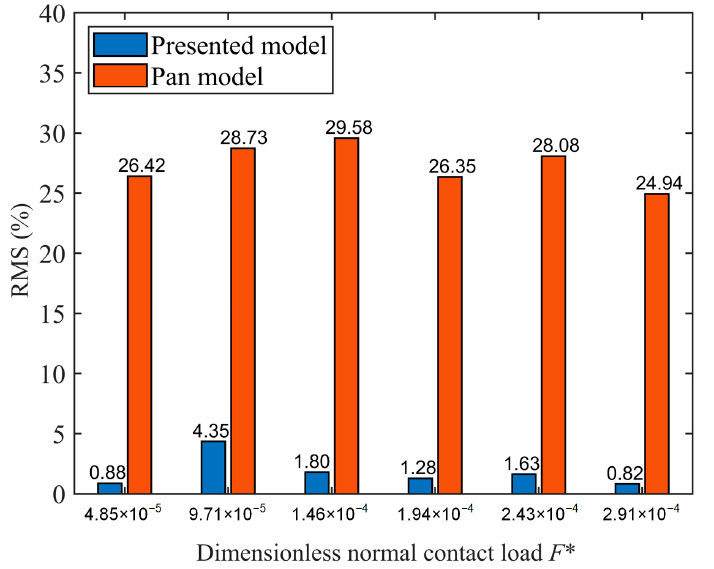
Figure 4. Relative errors between experimental results and simulation results of the presented model and the Pan model.